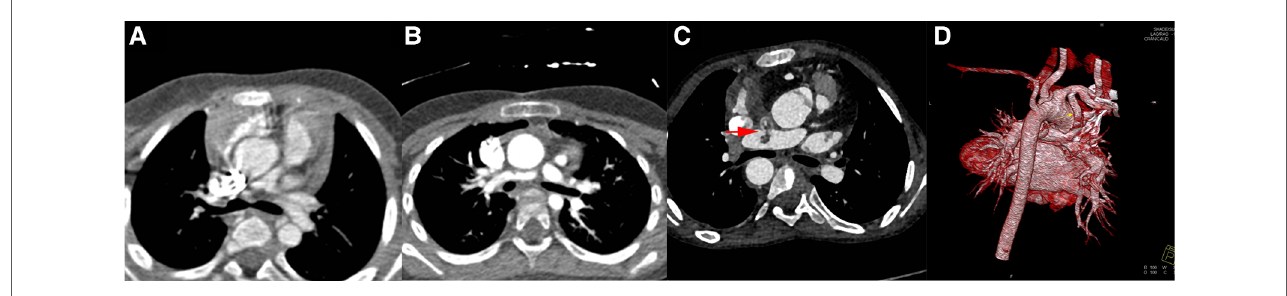
FIGURE 3 Images in mBTS group. Image ( A ), patients ’ pulmonary artery CTA image before procedure; Image ( B ), anastomotic stenosis; Image ( C ), shunt duct and RPA thrombosis; Image ( D ), 3D image before fi nal surgical repair. The red arrow indicates the